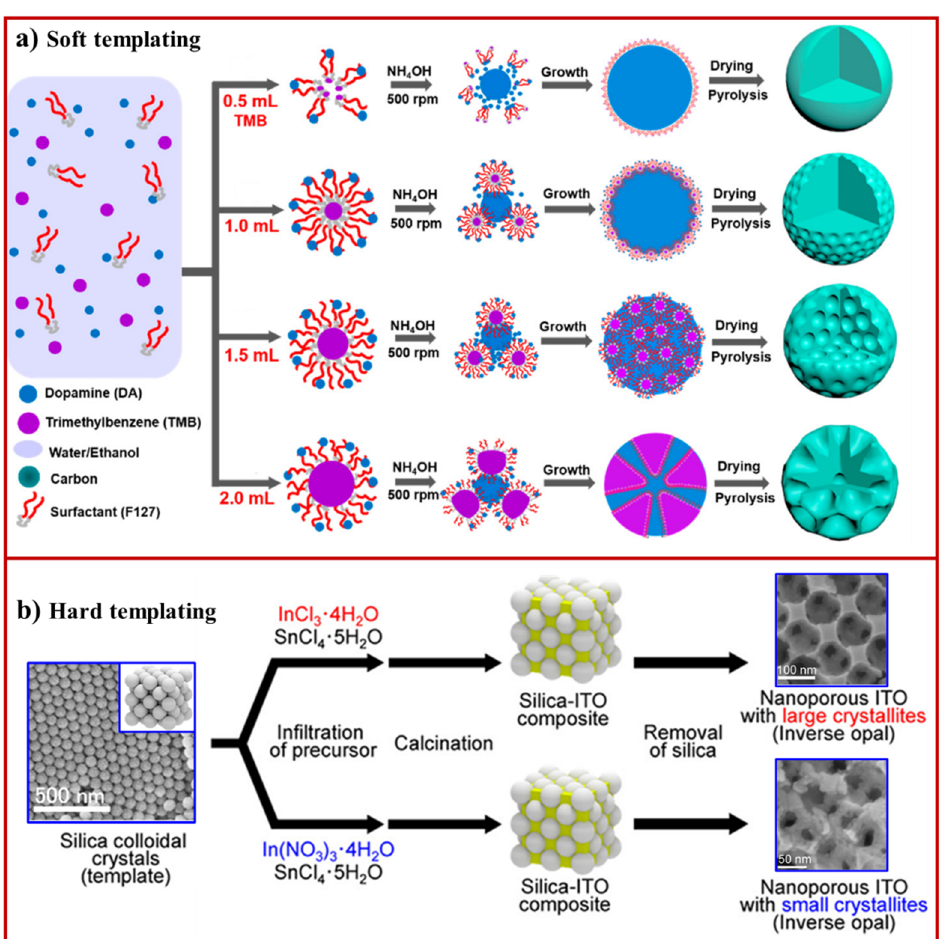
Figure 3. ( a ) Schematic illustration displaying the formation of nanoporous carbon in different morphologies depending on the ratio of surfactant to trimethylbenzene (TMB) in the soft micellar structure (adapted from [93], Copyright 2019, American Chemical Society); ( b ) fabrication of ordered nanoporous materials ITO using silica colloidal crystals as a hard template (adapted from [94], Copyright 2015, American Chemical Society).